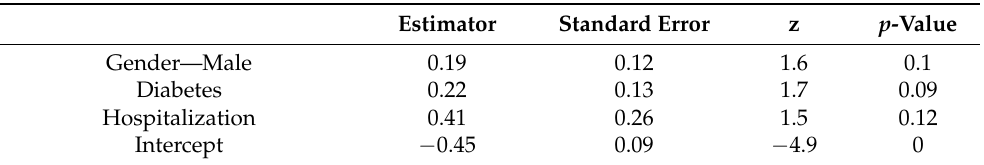
Table 5. Question seven—logistic regression model; four or more responses indicating the satisfactory level of knowledge.